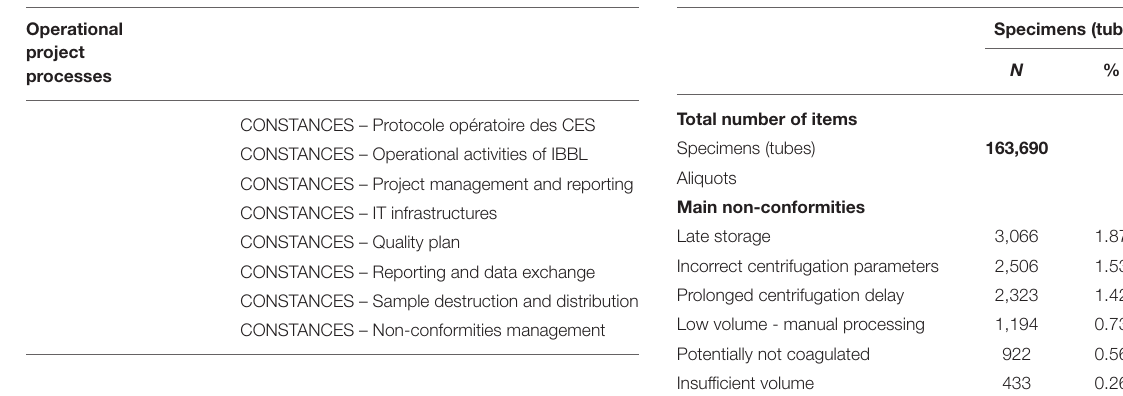
TABLE 4 | Constances Biobank Project Specific Operating Procedures. TABLE 5 | Relevant non-conformities and their